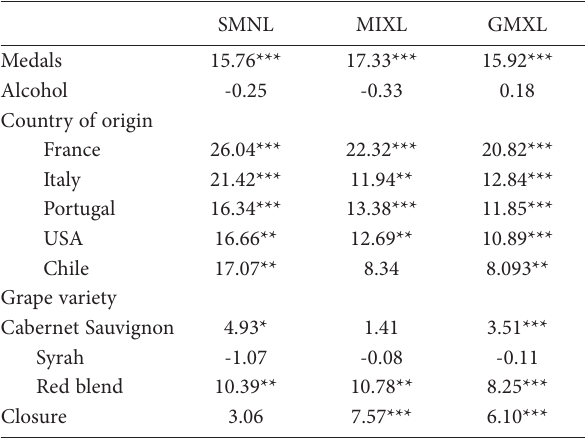
Table 4. Willingness to pay estimates 1 , in